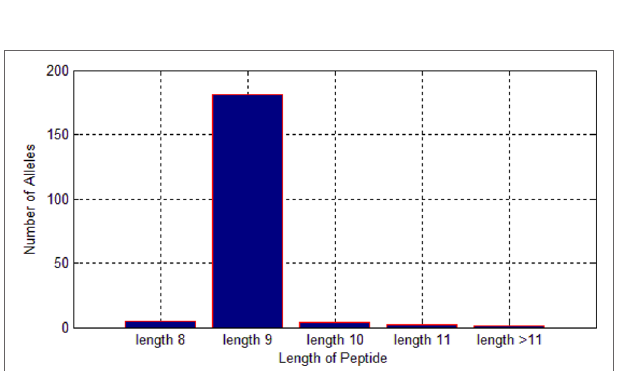
FIgURe 6 | Length preference of 193